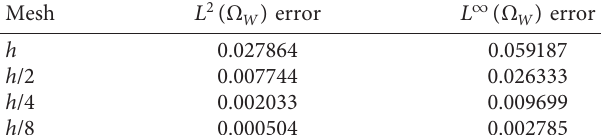
Figure 3: Mesh h of subdomain Ω Table 1: The errors with different meshes ( d � 1 ,N � 20 ) .